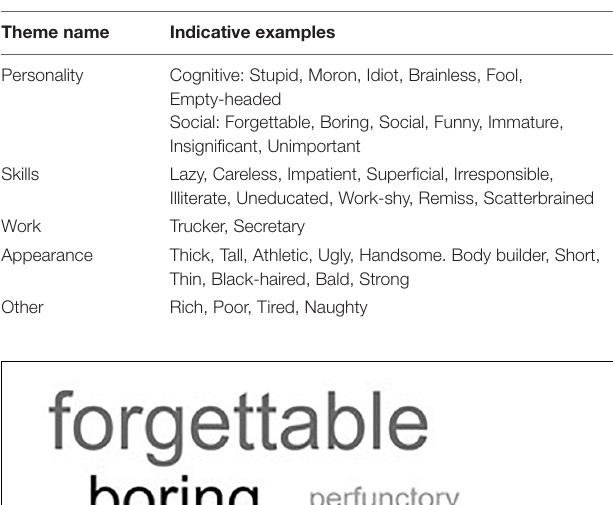
TABLE 5 | Framework for analysis of children’s responses to “What three adjectives would you NOT use to describe a scientist?”